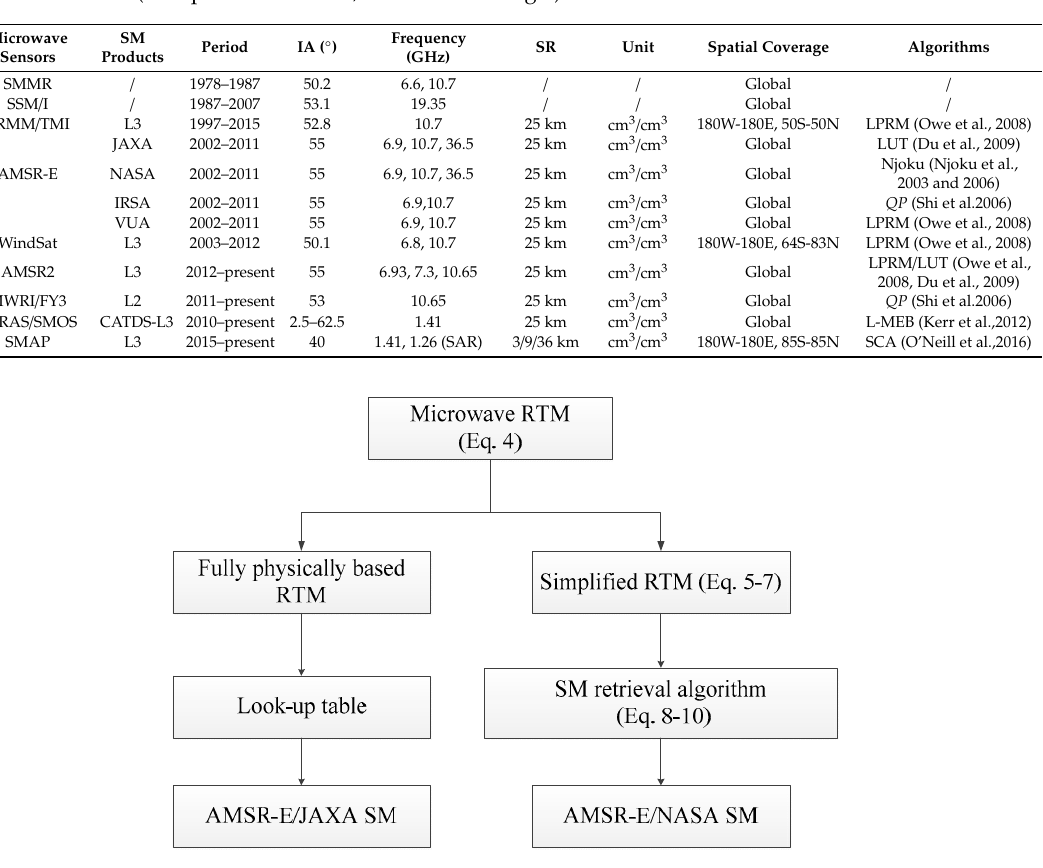
Table 1. Summary of long time series of soil moisture data retrieved from passive microwave radiometer observations (SR: spatial resolution; IA: incidence angle).